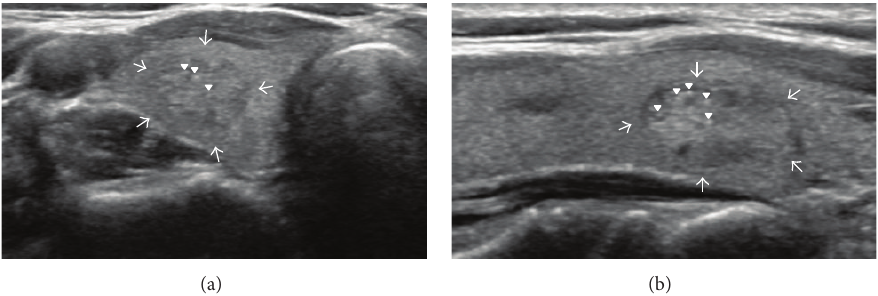
Figure 3: Initially suspicious but concordant nodule after imaging-cytology correlation. US scans ((a) transverse; (b) longitudinal) in a 54- year-old female without remarkable medical history show a 12 mm sized solid mass (arrows) with internal echogenic foci in the lower pole of the right lobe of the thyroid gland. The initial cytologic result was adenomatous hyperplasia which was concordant with US findings in imaging-cytology correlation after biopsy. At the time of imaging-cytology correlation, the echogenic foci (arrowheads) were thought to be related to colloids instead of microcalcifications from psammoma bodies. She underwent surgery (left total and right subtotal thyroidectomy) due to papillary carcinoma in the contralateral lobe of the thyroid gland. The mass in the right lobe was finally confirmed as adenomatous hyperplasia on